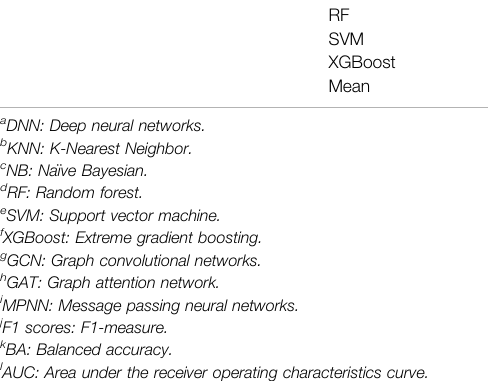
( Table 2 ) in both descriptor- and fi ngerprint-based models, while XGBoost also achieved comparable results for these 14 modeling datasets ( Table 2 and Figure 5A ); 2) among the established 56 graph-based models, Attentive FP architecture outperformed the other three deep graph learning approaches (i.e., GCN, MPNN, and GAT) on average across all 14 datasets ( Table 2 );